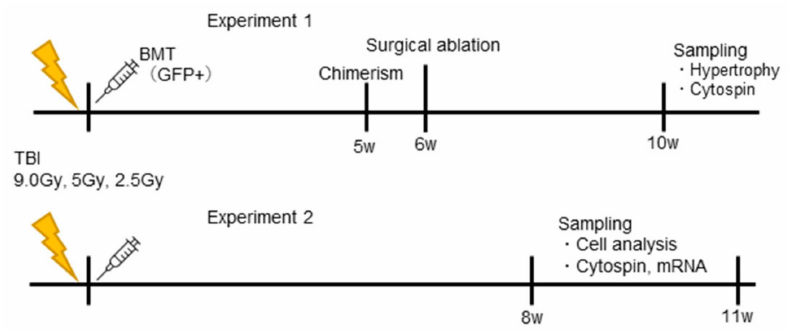
Figure 1. Experimental protocol. Experiment 1: Analysis of muscle hypertrophy. Experiment 2: Analysis of myogenic and proliferative capacity of the skeletal muscle-derived stem/progenitor